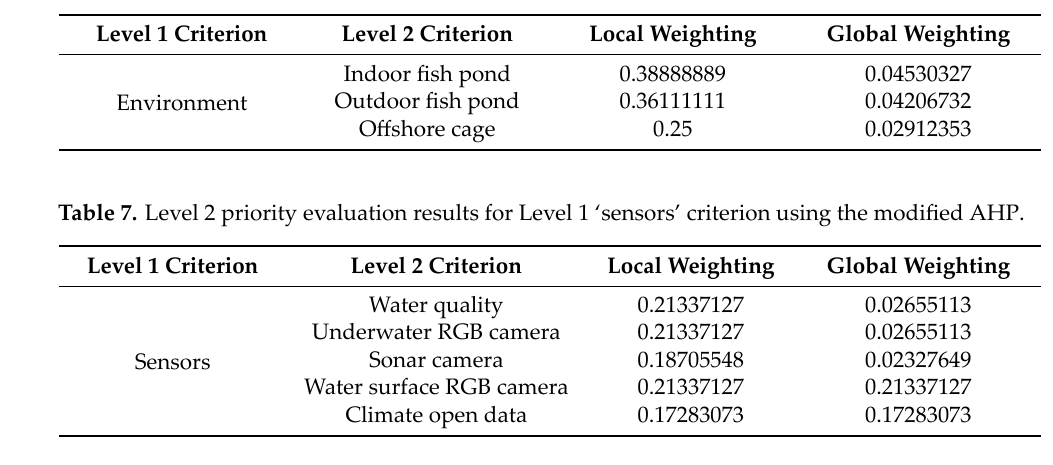
Table 6. Level 2 priority evaluation results for Level 1 ‘environment’ criterion using the modified AHP.